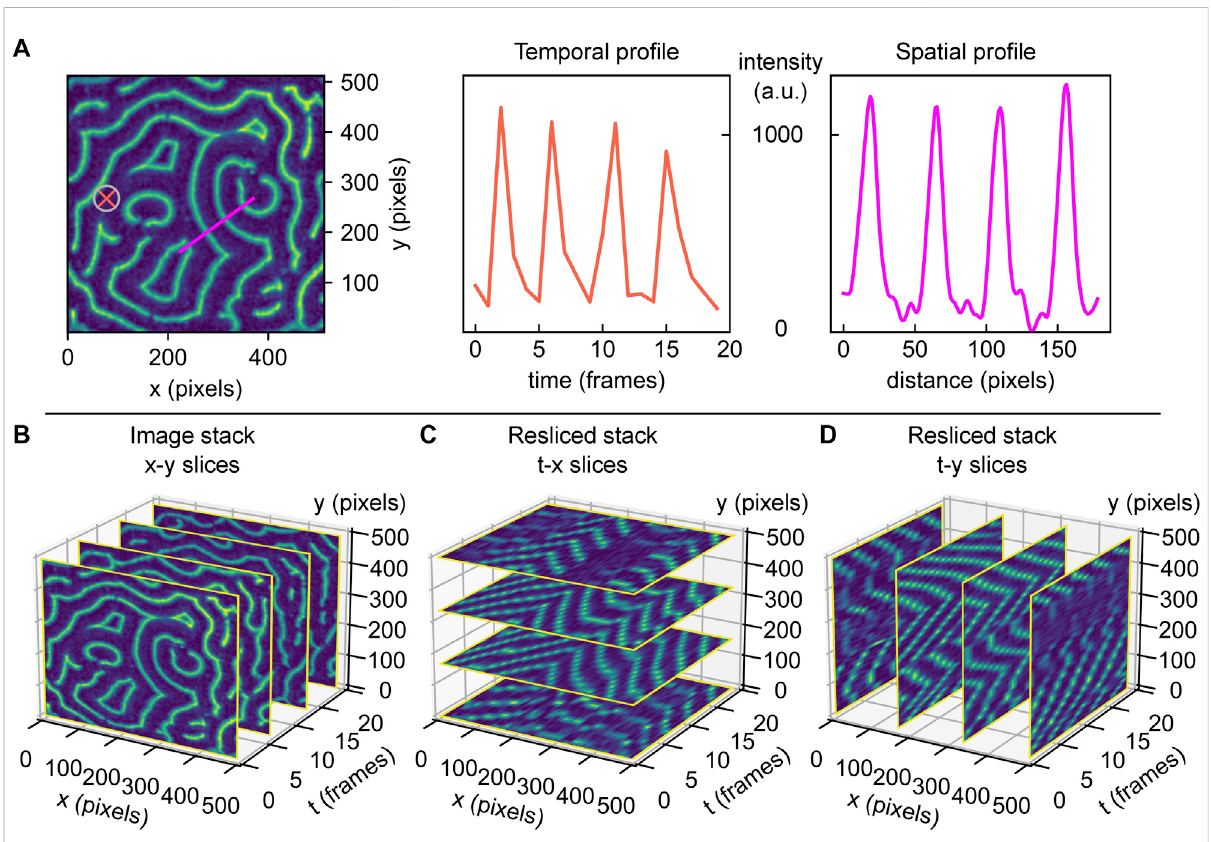
FIGURE 1 Min protein surface patterns are dynamic in space and time. Min pattern acquisitions are 3D ( x , y , t ) matrices, containing the measured fl uorescence intensity values for different coordinates. The information contained within this matrix can be accessed and visualized differently, dependentonwhatparametersareofinterest. (A) Left:exampleofarealMinEproteinsurfacepattern.Middle: fl uorescenceintensityovertimeatthe surfacepositionhighlightedbyorangecrossintheimage,foranimagestack comprisingof20frames.Right: fl uorescenceintensity tracealong surface cross-section highlighted in magenta in the image. (B) 3D view of a Min protein acquisition stack with four example images (standard x - y slices) shown for demonstration. (C) 3D view of slice from A, resliced along constant y -directions, creating t - x slices. (D) 3D view of slice from A, resliced along constant x -directions, creating t - y